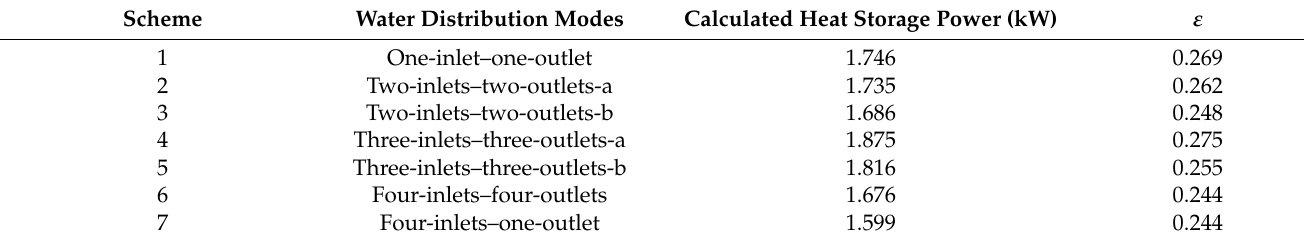
Table 12. Temperature increase slope of reservoir unit load corresponding to different water distribu- tion